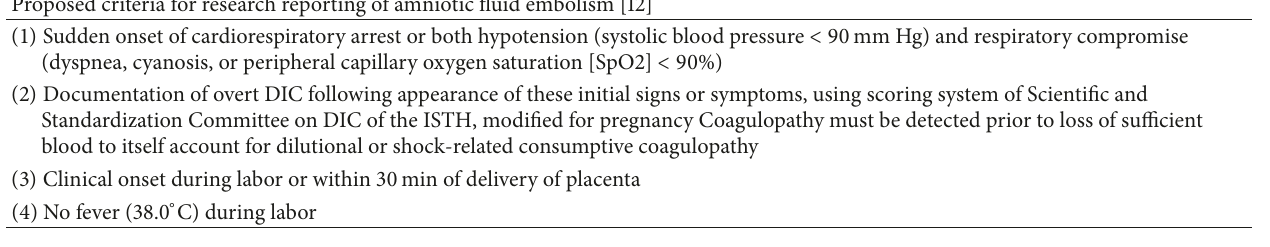
Proposed criteria for research reporting of amniotic fluid embolism [12]